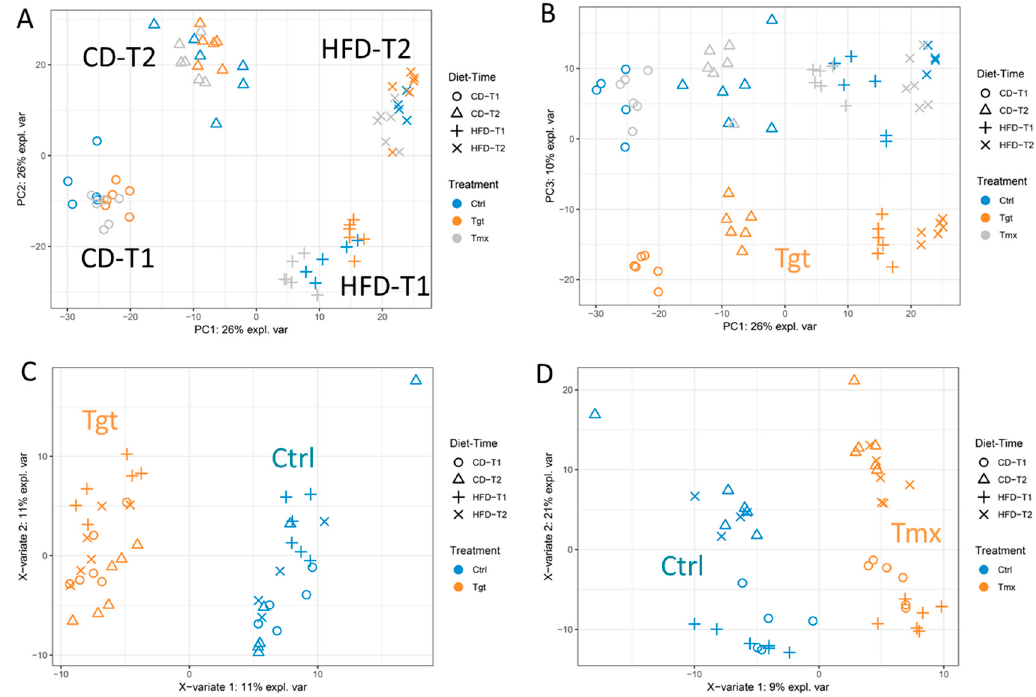
Figure 2. Multivariate analysis of all quantified metabolites. ( A) and ( B ) the scores plots of the PCA analysis, ( C) and ( D ) the scores plots of the PLS-DA analysis. Diets: standard diet (CD); high fat diet (HFD); Times: T1, 78 days of age; T2, 190 days of age; Treatments: Ctrl, control; Tgt, targretin; Tmx, tamoxifen.